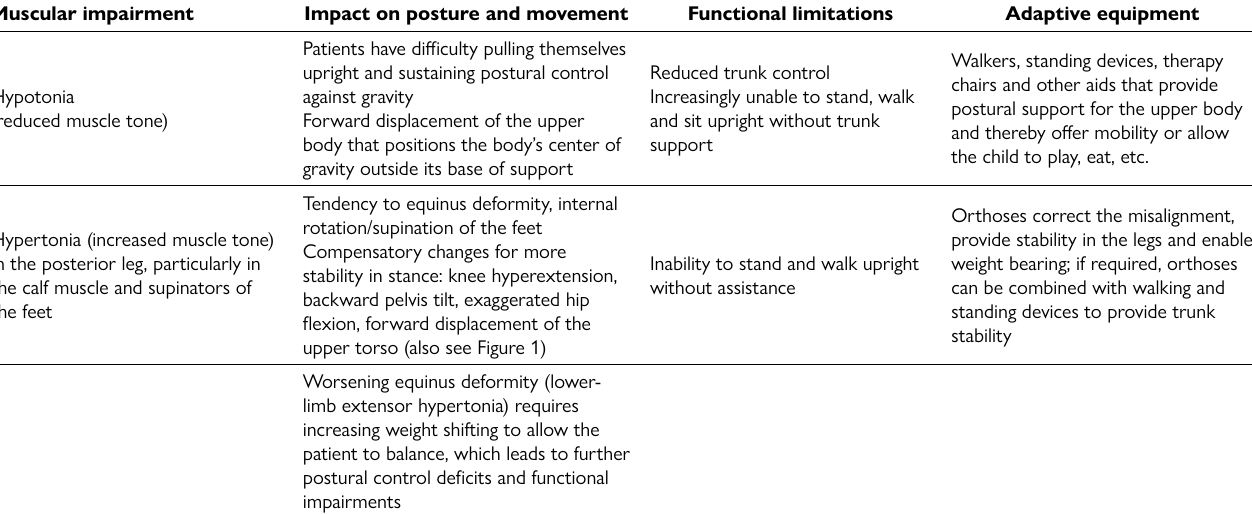
Table 1. Prevalent sensorimotor symptoms associated with CLN2 disease and their effect on patients observed at the Paediatric Physiotherapy Practice in Hamburg,